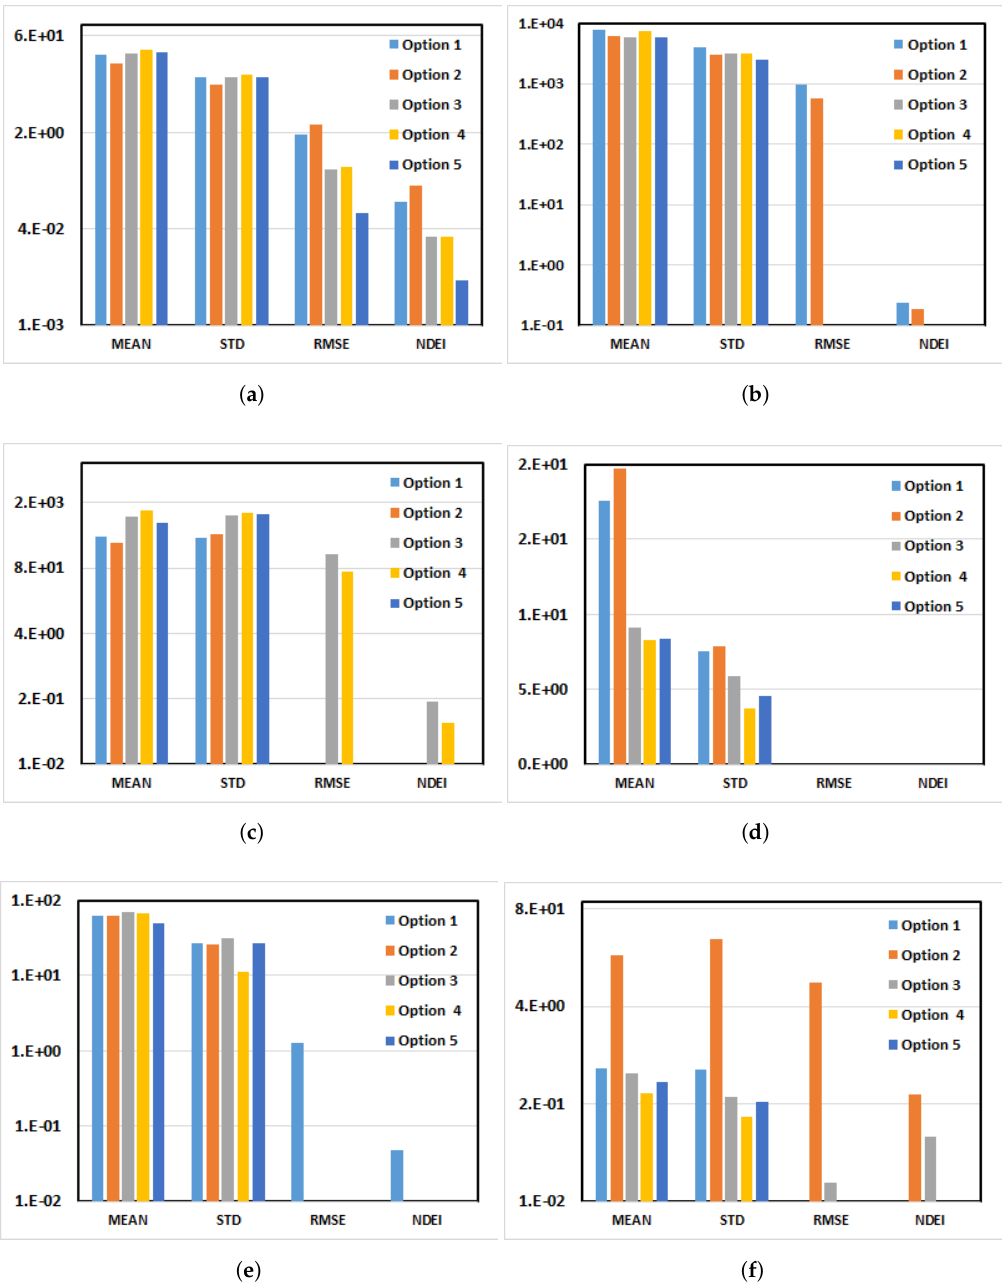
Figure A3. Statistical data plots of worldwide successful gas injection EOR projects for the variables: ( a ) API; ( b ) depth; ( c ) permeability; ( d ) porosity; ( e ) saturation; and ( f )